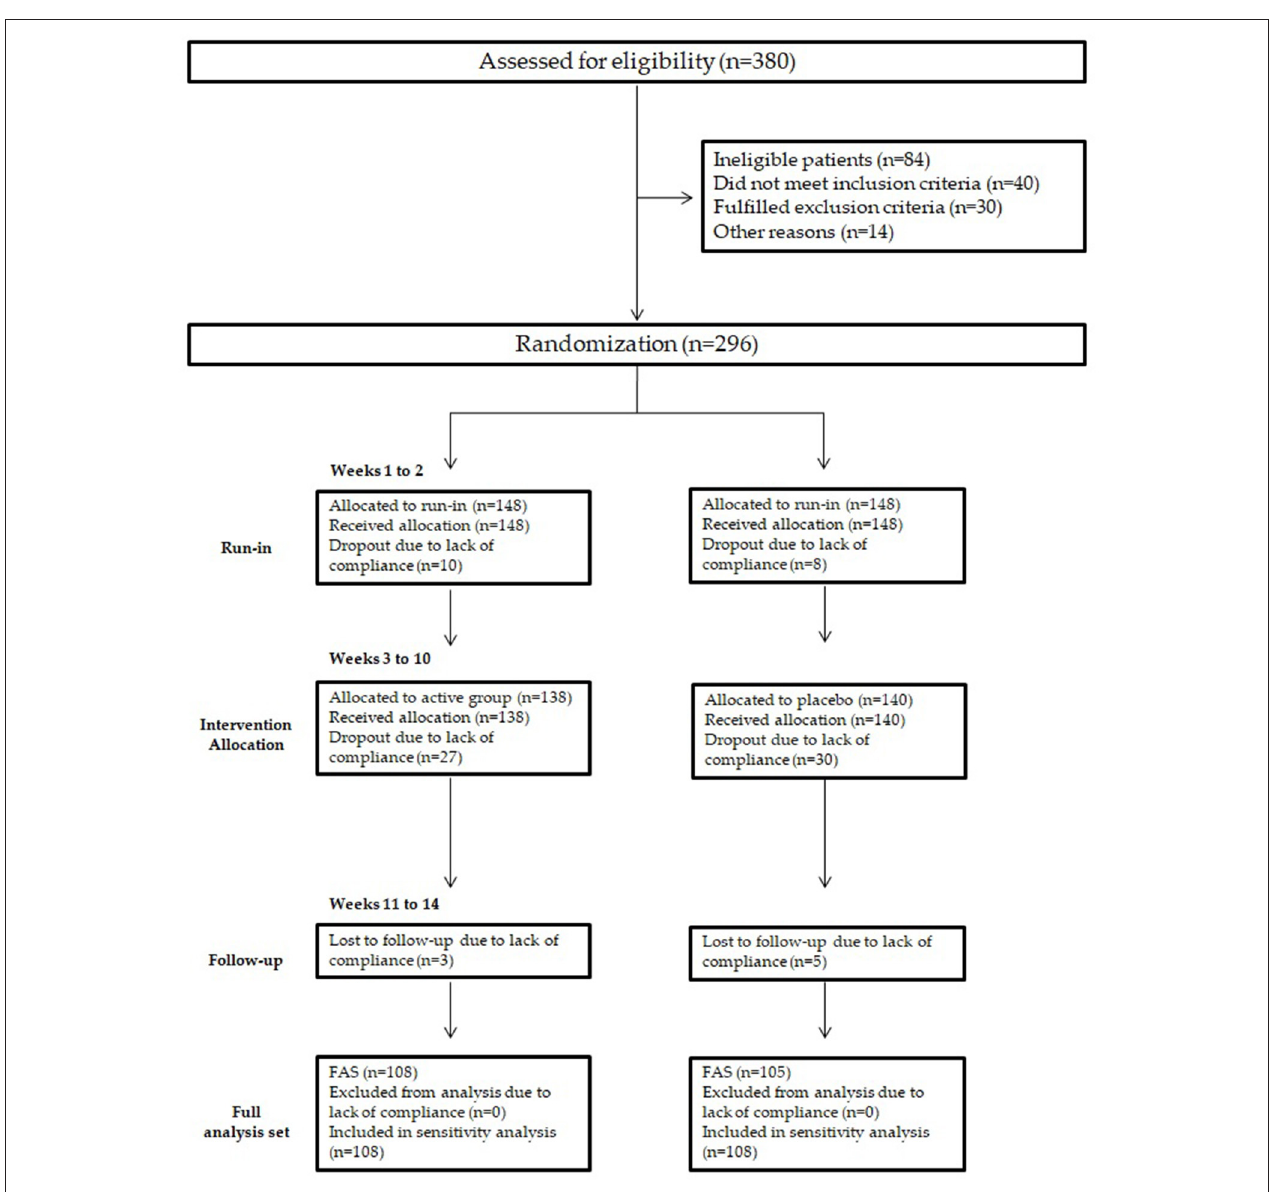
FIGURE 1 | Study flowchart. Study flowchart, according to the consolidated standards of reporting trials (CONSORT). The diagram shows enrolment and primary efficacy endpoints based on patients’ diaries, from prescreening to data collection; and the extent of exclusions, loss to follow-up, and completeness of. Diary documentation available across the entire trial period. FAS, Full analysis